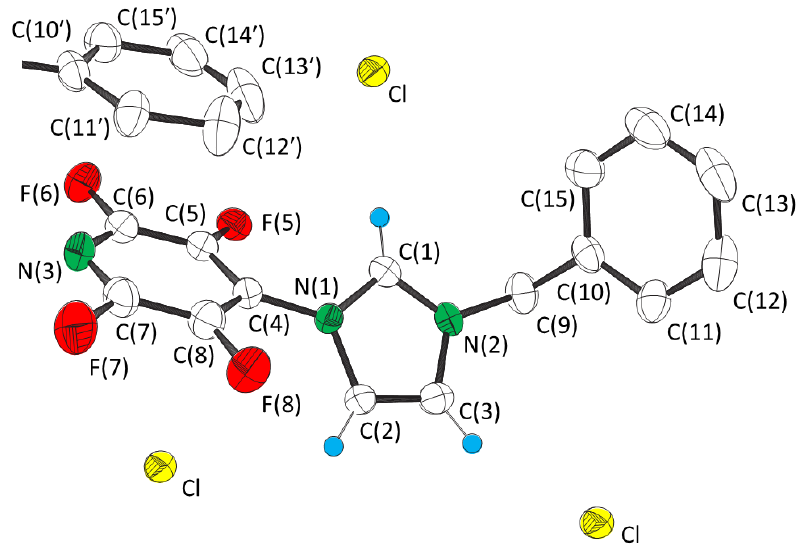
Figure 1. The structure of the cation of 1-(2,3,5,6-tetrafluoro-4-pyridyl)-3-benzylimidazolium chloride ( 1 ) indicating the positions of the three closest chloride anions and the phenyl ring of an adjacent cation. Thermal ellipsoids are at the 50% level. Hydrogen atoms not involved in hydrogen bonding are omitted for clarity.